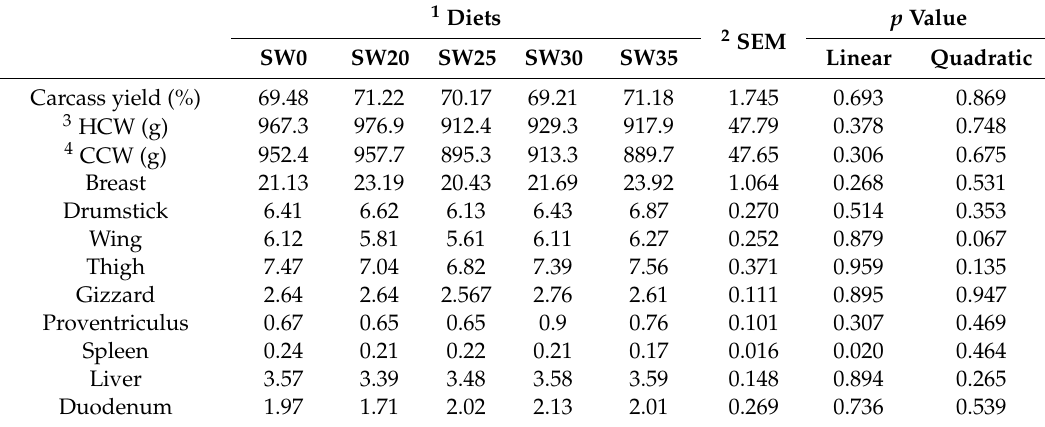
Table 5. The e ff ects of seaweed meal-containing diets on carcass characteristics and internal organ weights (% HCW, unless stated otherwise) of Cobb 500 broiler